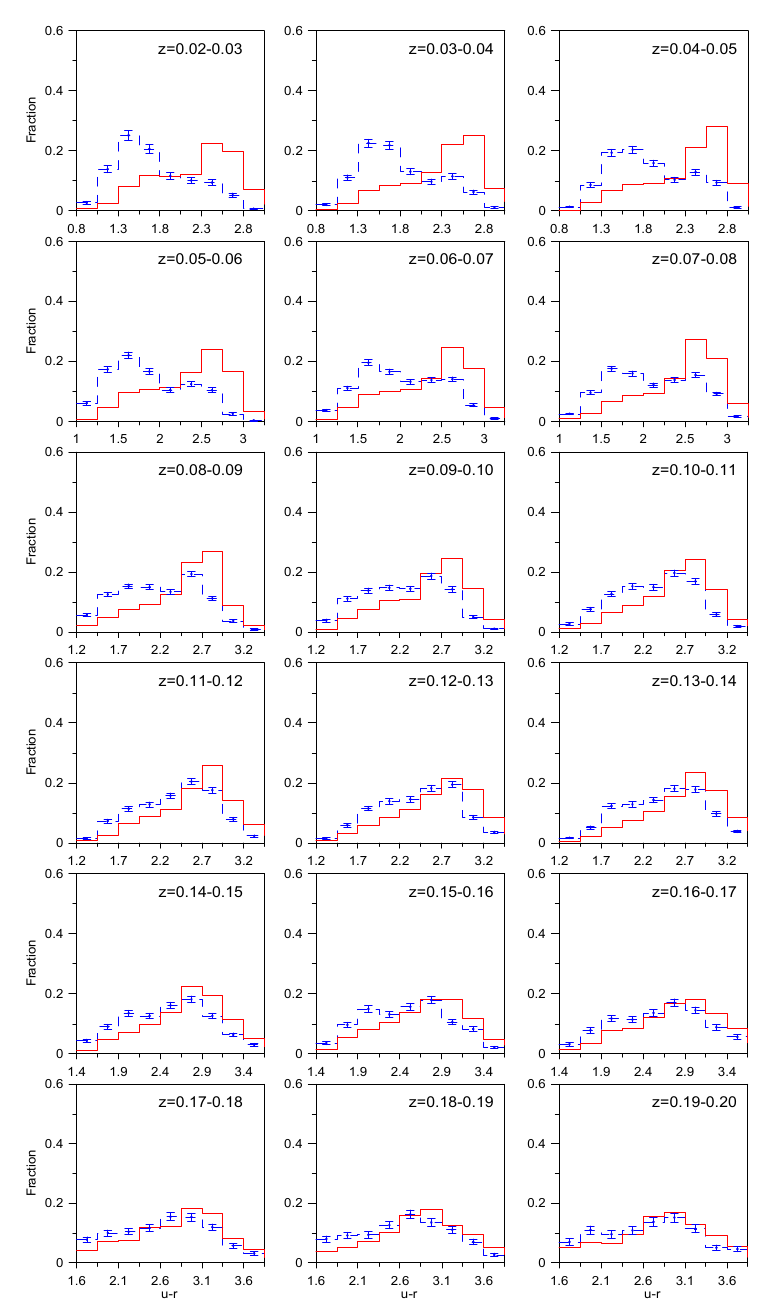
Fig. 1. Distribution of u – r colors at both extremes of density in different redshift bins: the red solid line is for the sample at high density, and the blue dashed line is for the sample at low density. The error bars of blue lines are 1 (cid:27) Poissonian errors. The error bars of red lines are omitted for